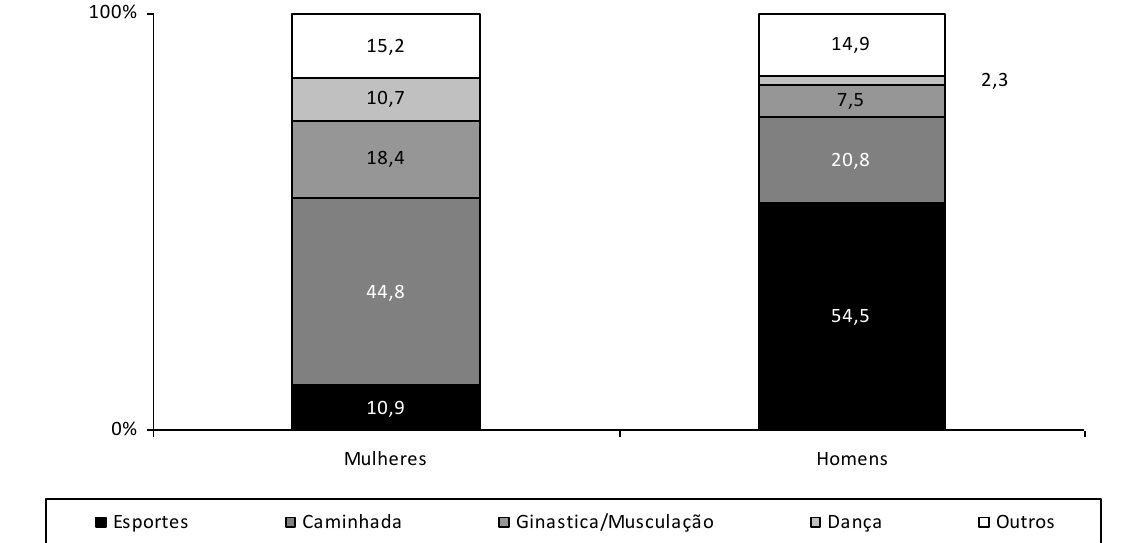
Figura 1. Tipo principal de atividade física no lazer em homens e mulheres trabalhadores da indústria do Rio Grande do Sul, 2007.(p=0,003).